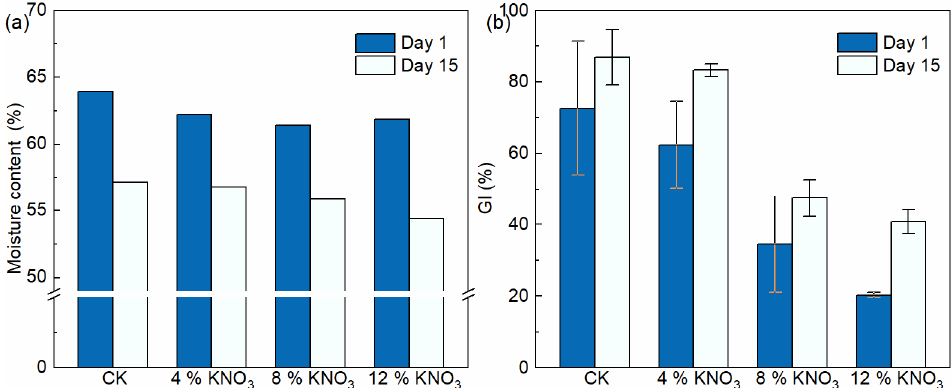
Figure 6. Changes in the moisture content ( a ) and GI ( b ) of the compost material under different KNO 3 additions.